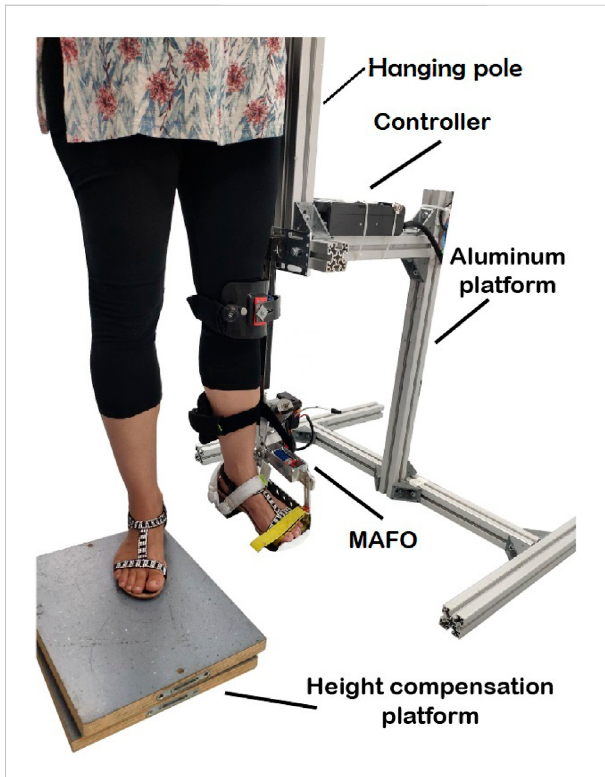
FIGURE 1 Volunteer following a torque pro fi le trajectory with the ankle during MAFO